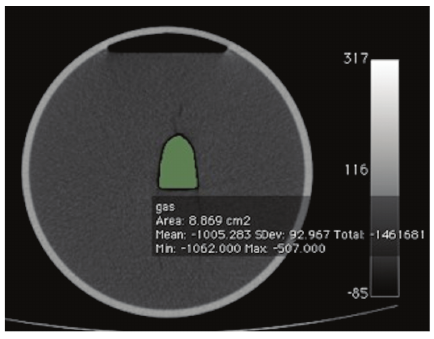
Figure 3: Axial image through a gas containing phantom. Multiple analyses with varying hounsfield values allowed us to find the most accurate range during quantitative estimation to be − 350 HU to − 1024HU.